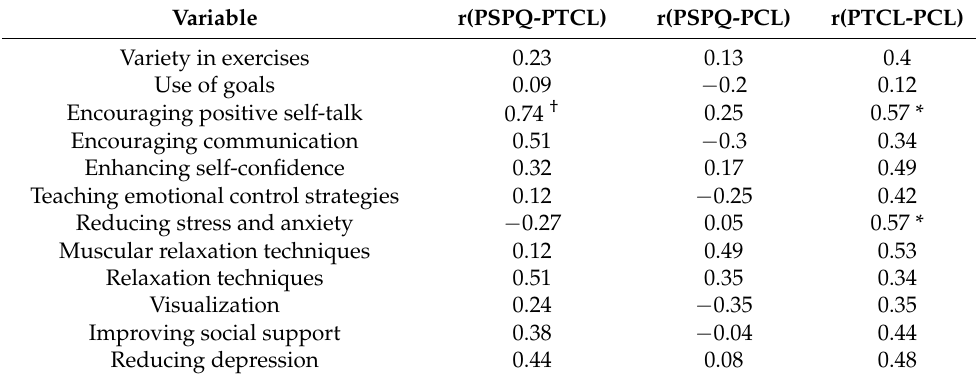
Table 1. Spearman correlations between physical therapists’ responses to the PSPQ items and physical therapists’ and patients’ responses to the behavioral checklist